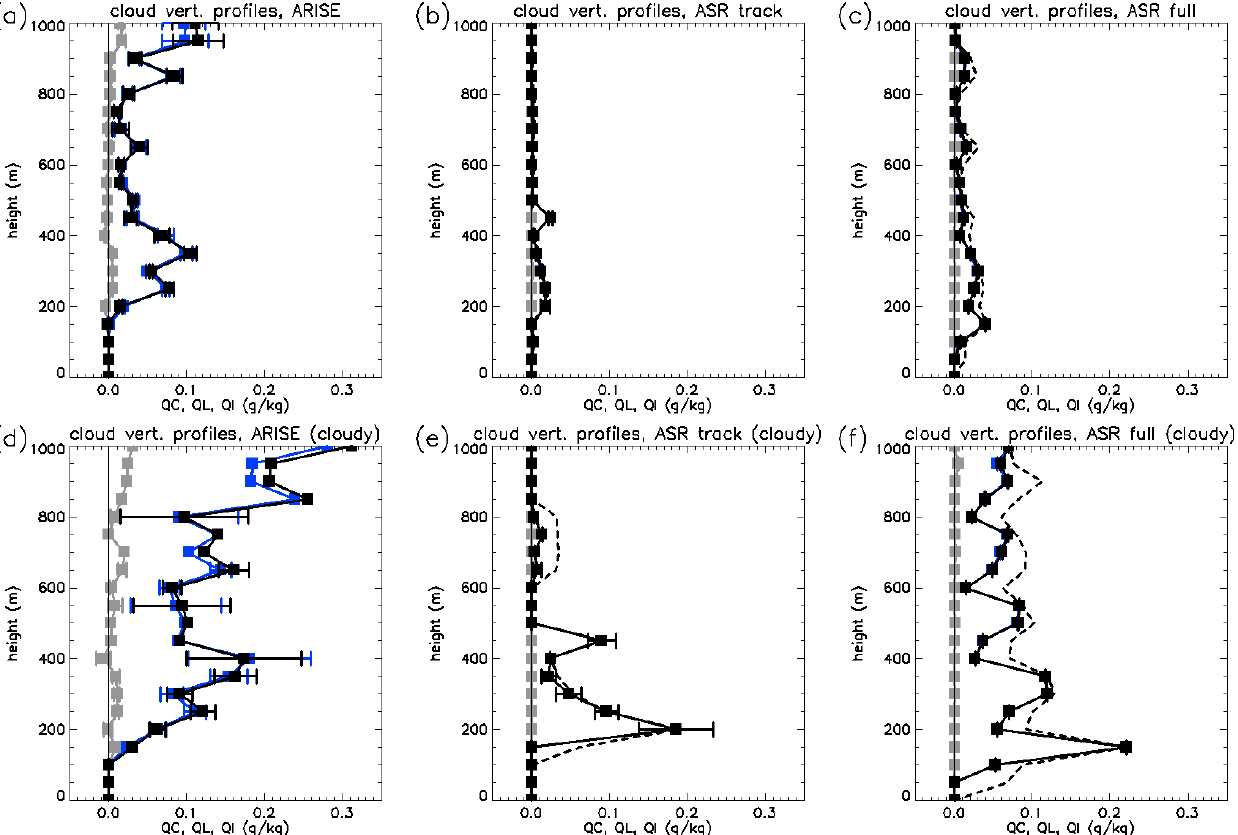
Figure 4. (a) The vertical profile of cloud water (QC, black), cloud liquid (QL, blue), and cloud ice (QI, gray) for all ARISE data collected from below 1000m. (b) Same as (a) , but for ASR along the ARISE flight tracks. In addition, the dashed black line has precipitation included with the cloud water. (c) Same as (b) , but for the full ASR dataset from the Beaufort Seas domain. (d–f) Same as (a–c) , but for cloud-only pixels.